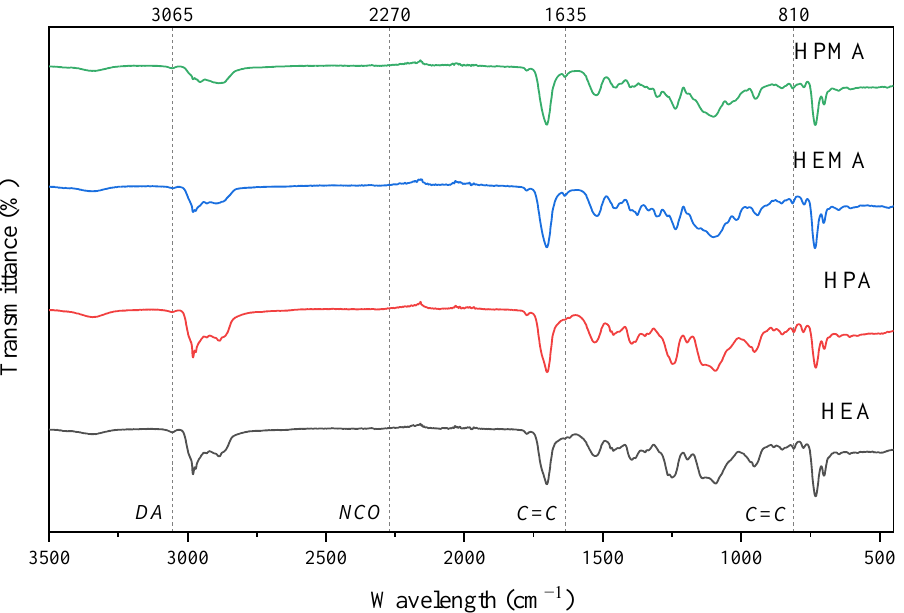
Figure 3. FTIR spectra of urethane (meth)acrylates obtained.